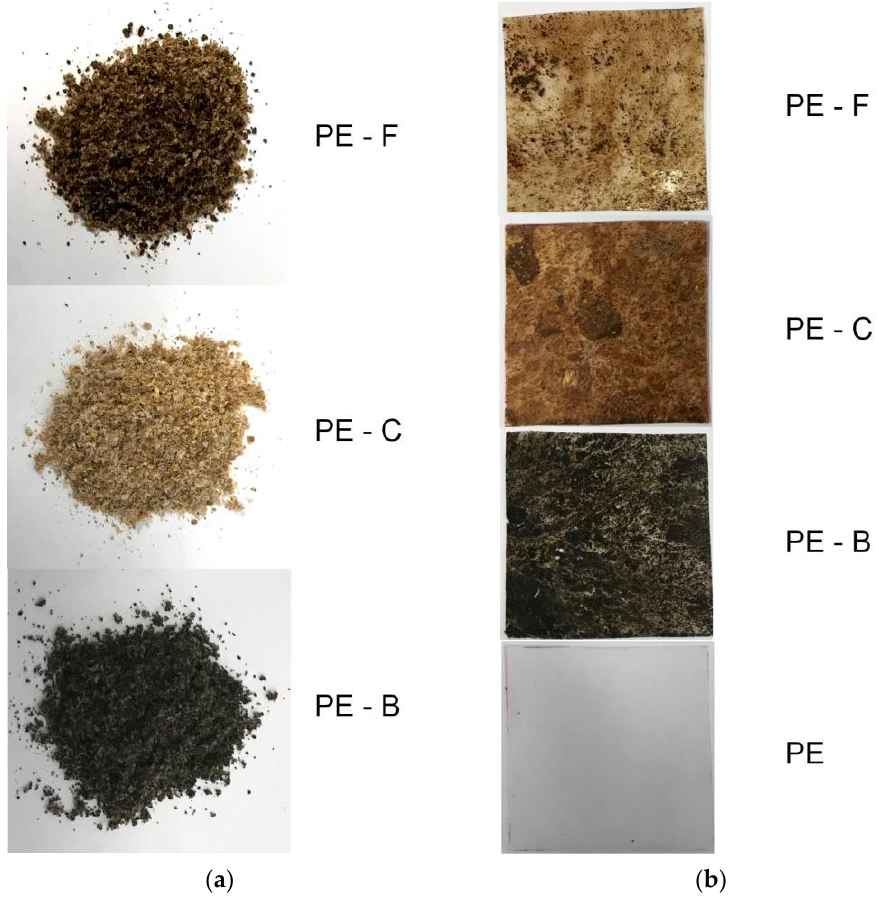
Figure 1. ( a ) PE – pomace plant-based ground composites; ( b ) PE – pomace plant-based membranes. Figure 1. ( a ) PE–pomace plant-based ground composites; ( b ) PE–pomace plant-based